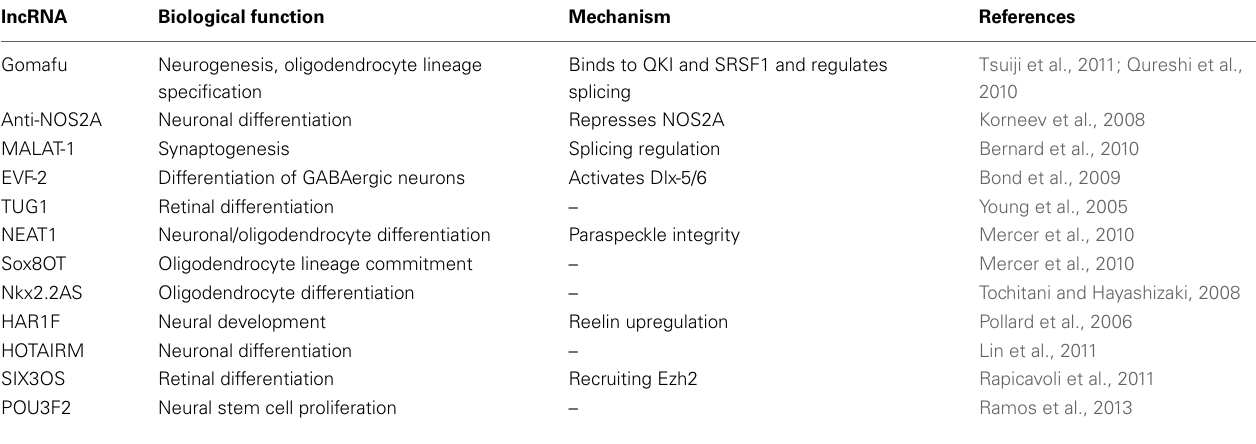
Table 1 | Summary of lncRNAs involved in the development of the nervous system. lncRNA Biological function